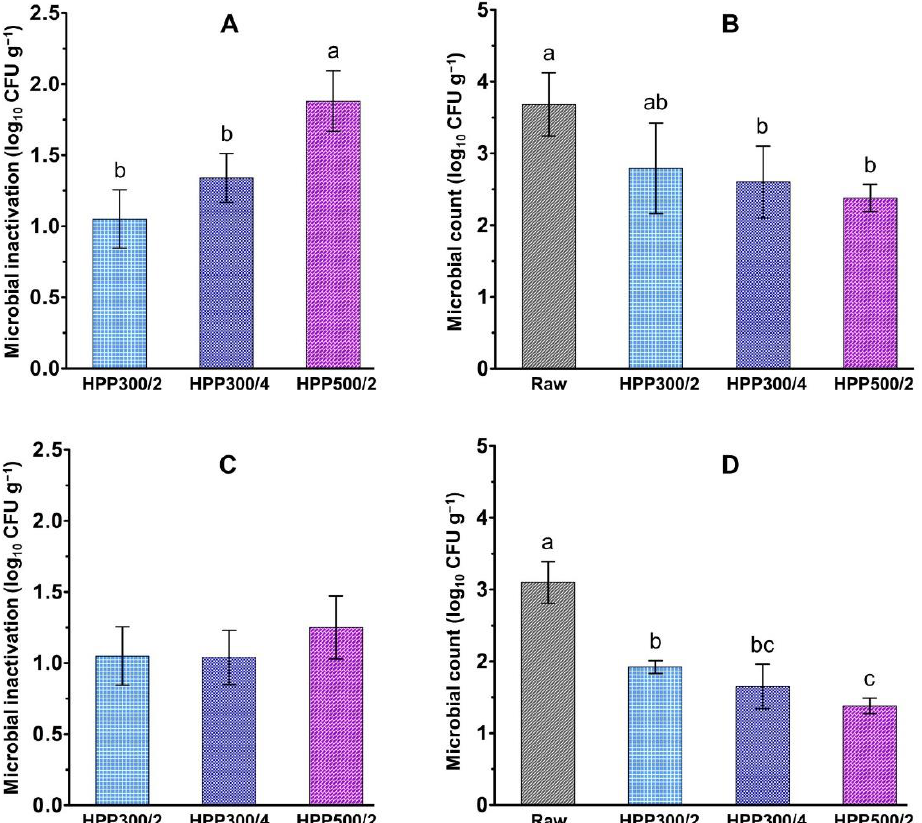
Figure 5. Left side: HPP-induced inactivation (log 10 CFU g − 1 ) of total viable psychrotrophic ( A ) and mesophilic ( C ) counts in claw meat. Right side: Total viable psychrotrophic ( B ) and mesophilic ( D ) counts (log 10 CFU g − 1 ) in the meat extracted from the claw of raw (i.e., untreated) and high-pressure processed chelipeds stored for two days at 4 °C after crab euthanization or HPP treatment. Error bars indicate standard deviations of the mean values. Different letters within a sub-plot indicate significantly ( p < 0.05) different mean values.